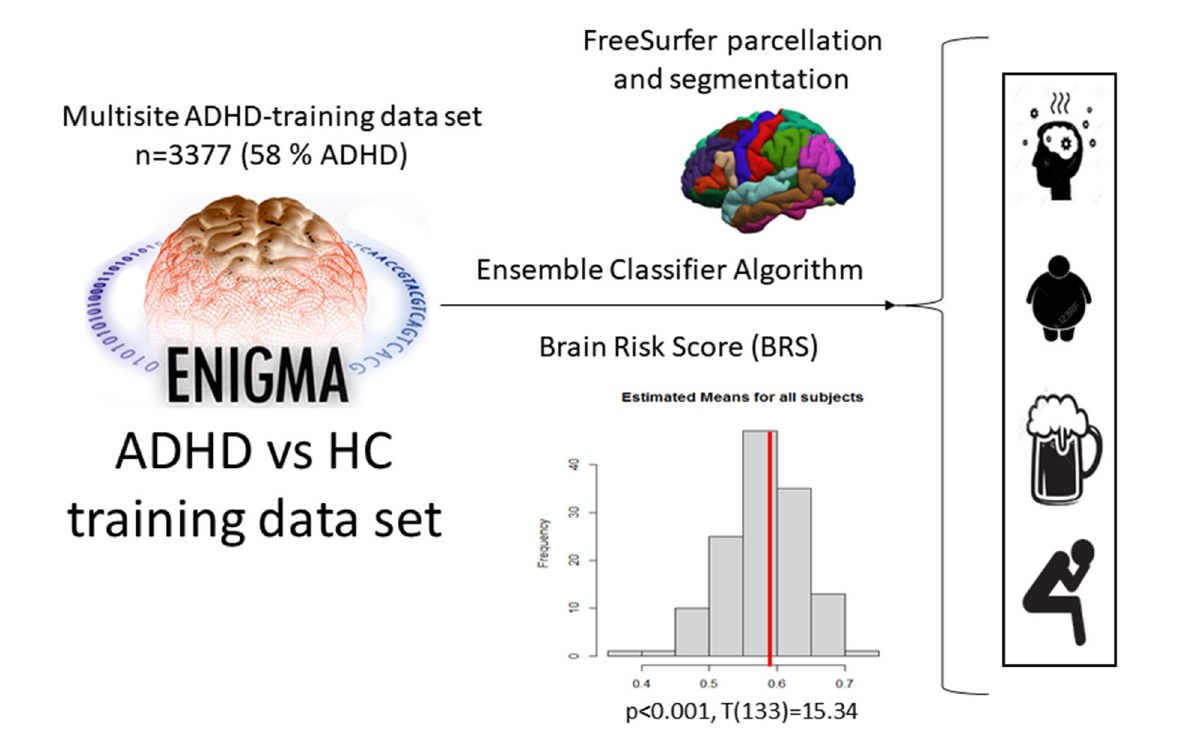
FIGURE1 Application of the ML ensemble classifier algorithm, which was used to estimate the BRS for ADHD in our current sample based on the ENIGMA cohort data, and then applied to classify different comorbidities in ADHD.